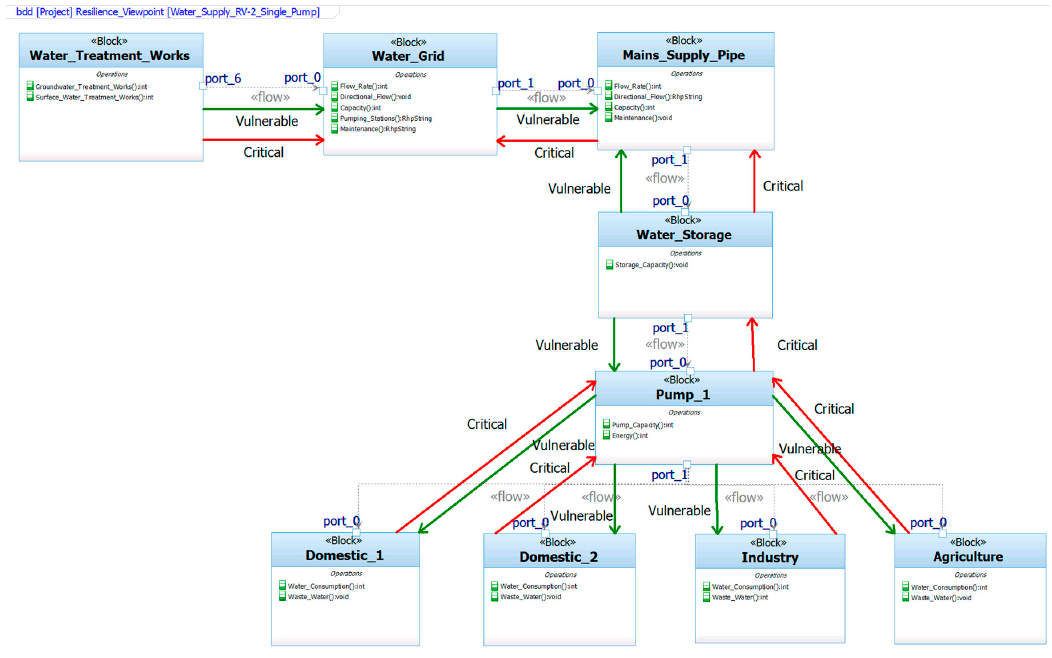
Figure 10. Resilience View 2 (RV-2) pump failure.